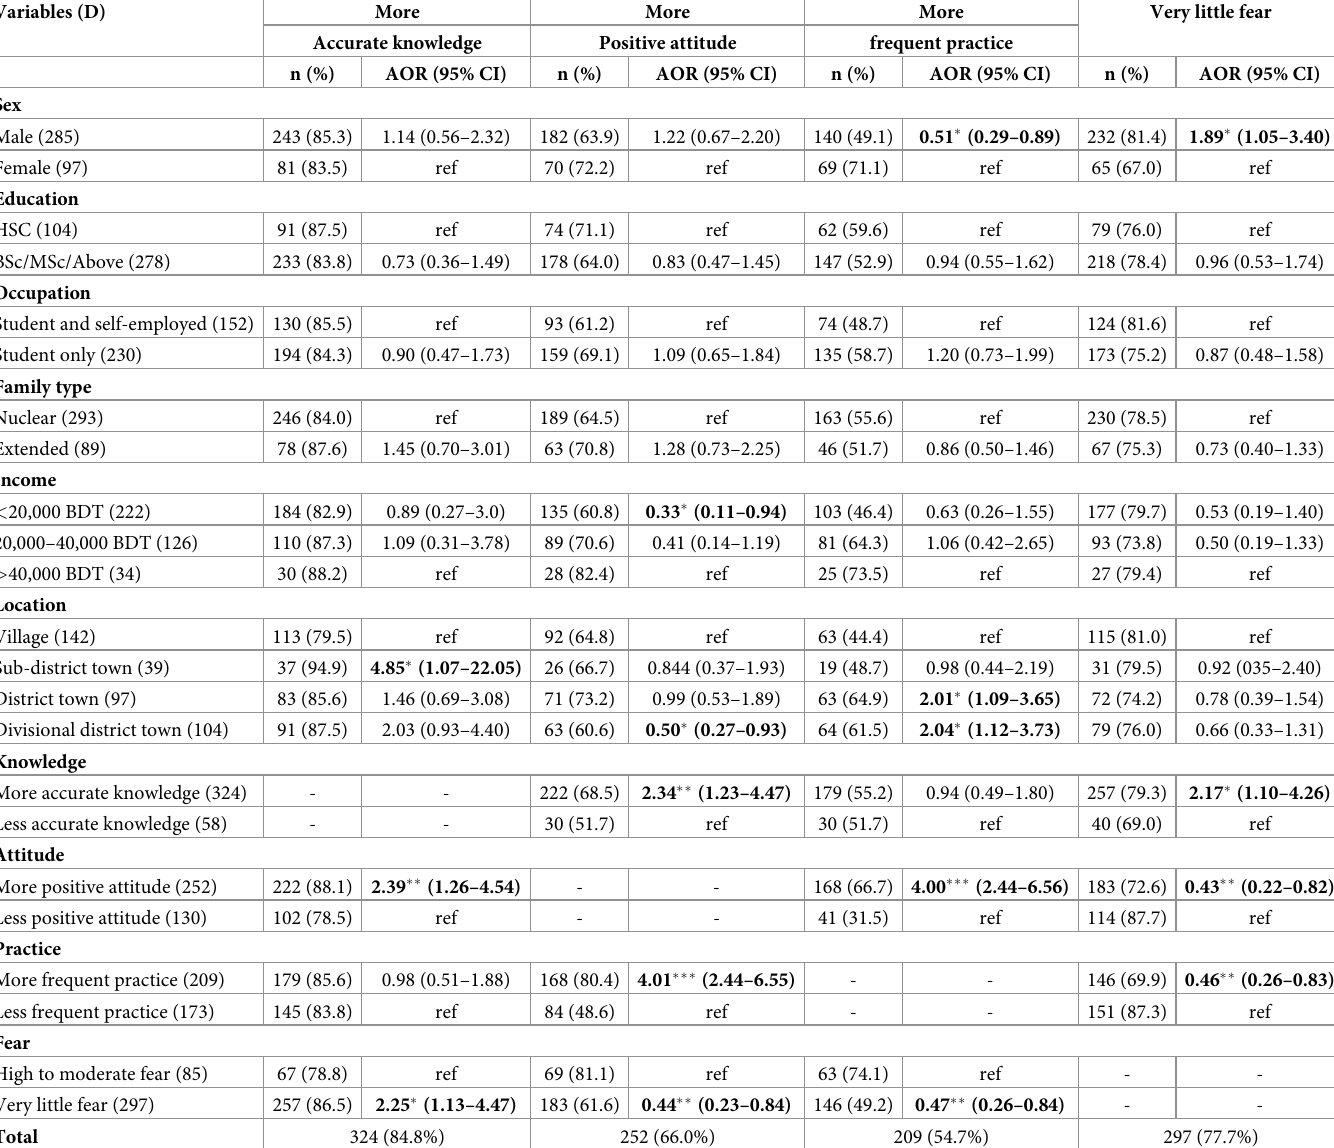
Table 5. Results of multiple logistic regression on factors associated with knowledge, attitude, practice, and fear. (Adjusted model). Variables (D) More More More Very little